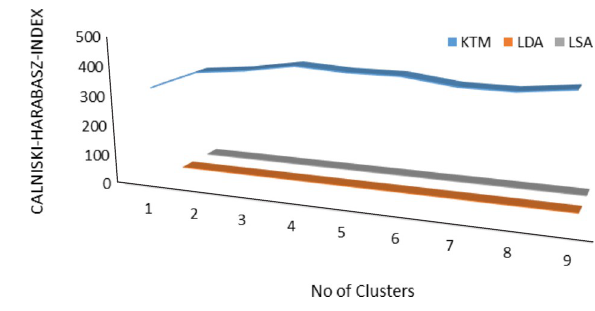
FIG. 11. CALINSKI-HARABASZ FOR 200 TOPICS OF BBC